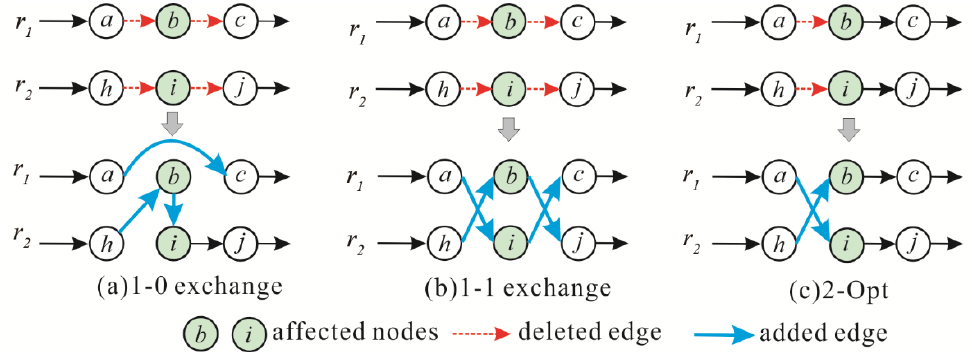
Figure 5. Local search operators ( a ) 1-0 exchange; ( b ) 1-1 exchange; and ( c )